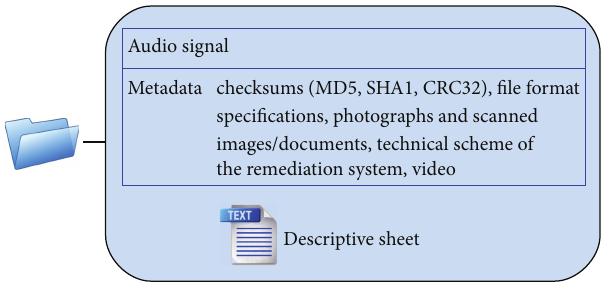
Figure 2: Logical representation of the elements contained in a preservation